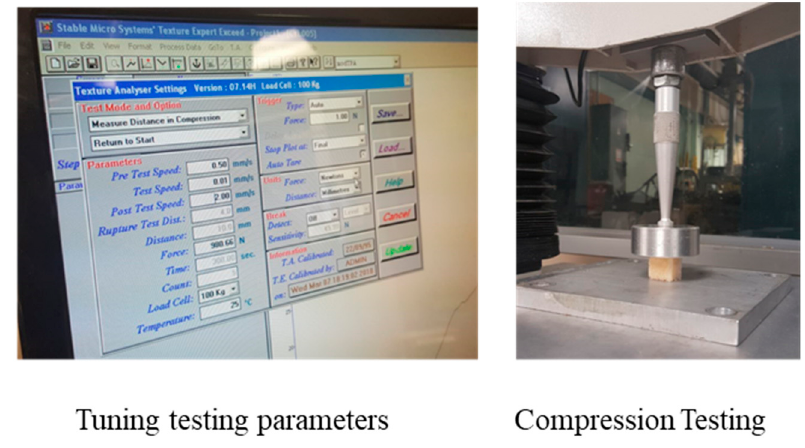
Figure 4. Compression testing of the bone specimens.